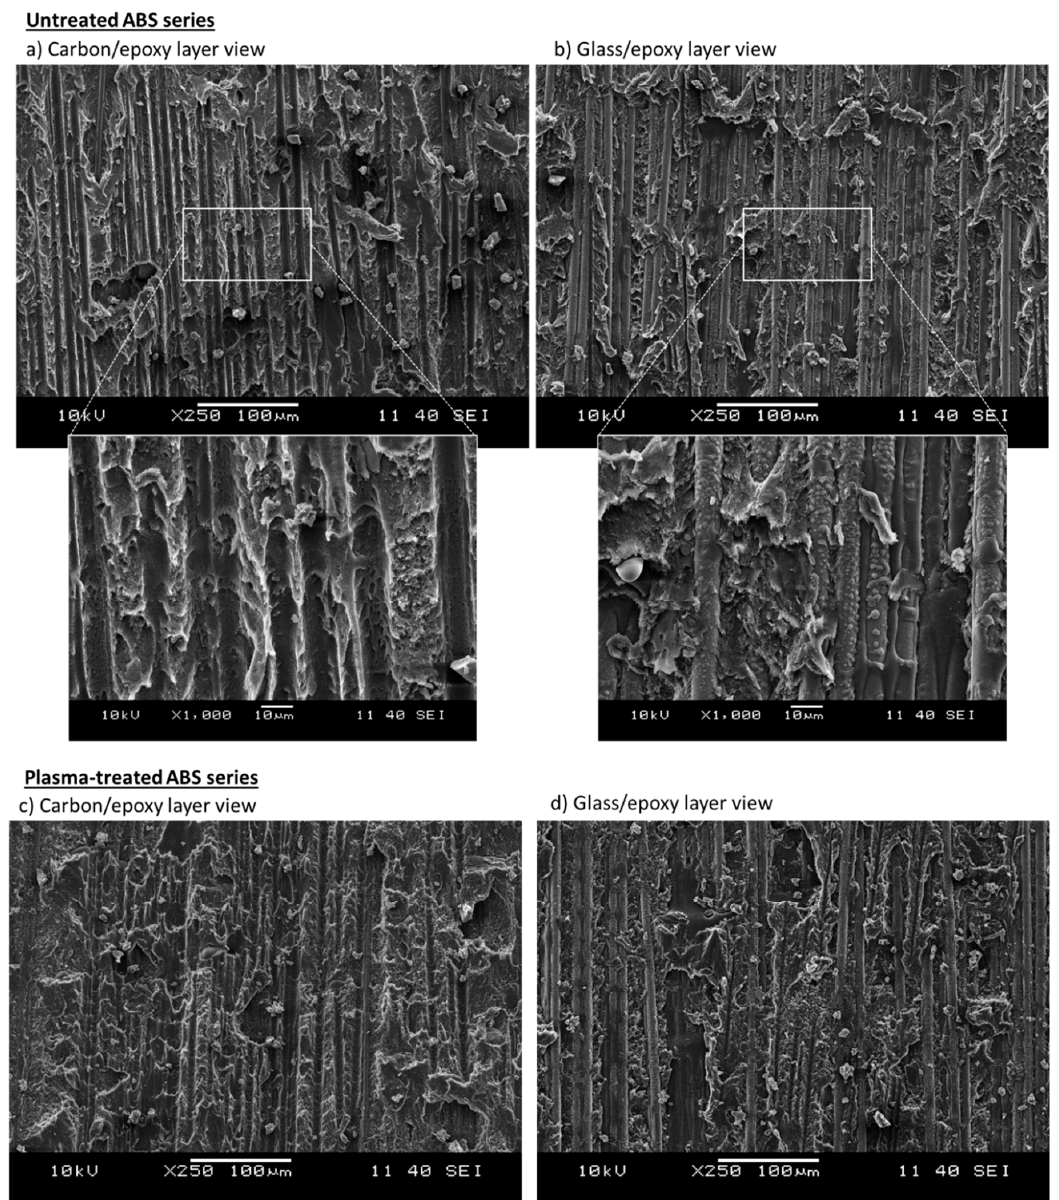
Figure 10. Delaminated surfaces of typical specimens from the ABS ( a ), ( b ) and the plasma-ABS (( c ), ( d )) series analysed with SEM.